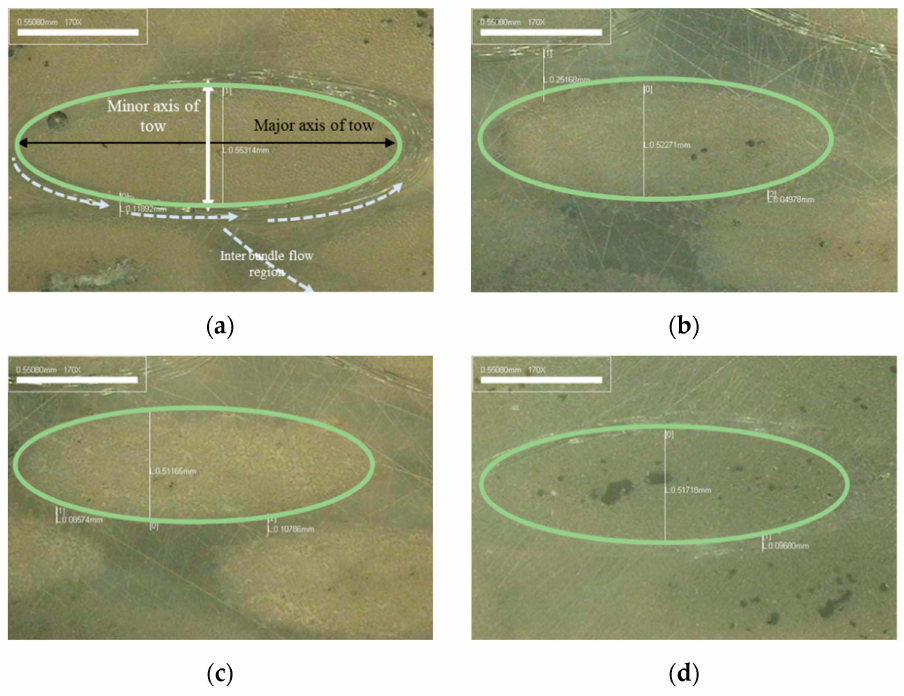
Figure 8. Microscopic images of the tow in the fiber bundle from the inlet to the outlet position at